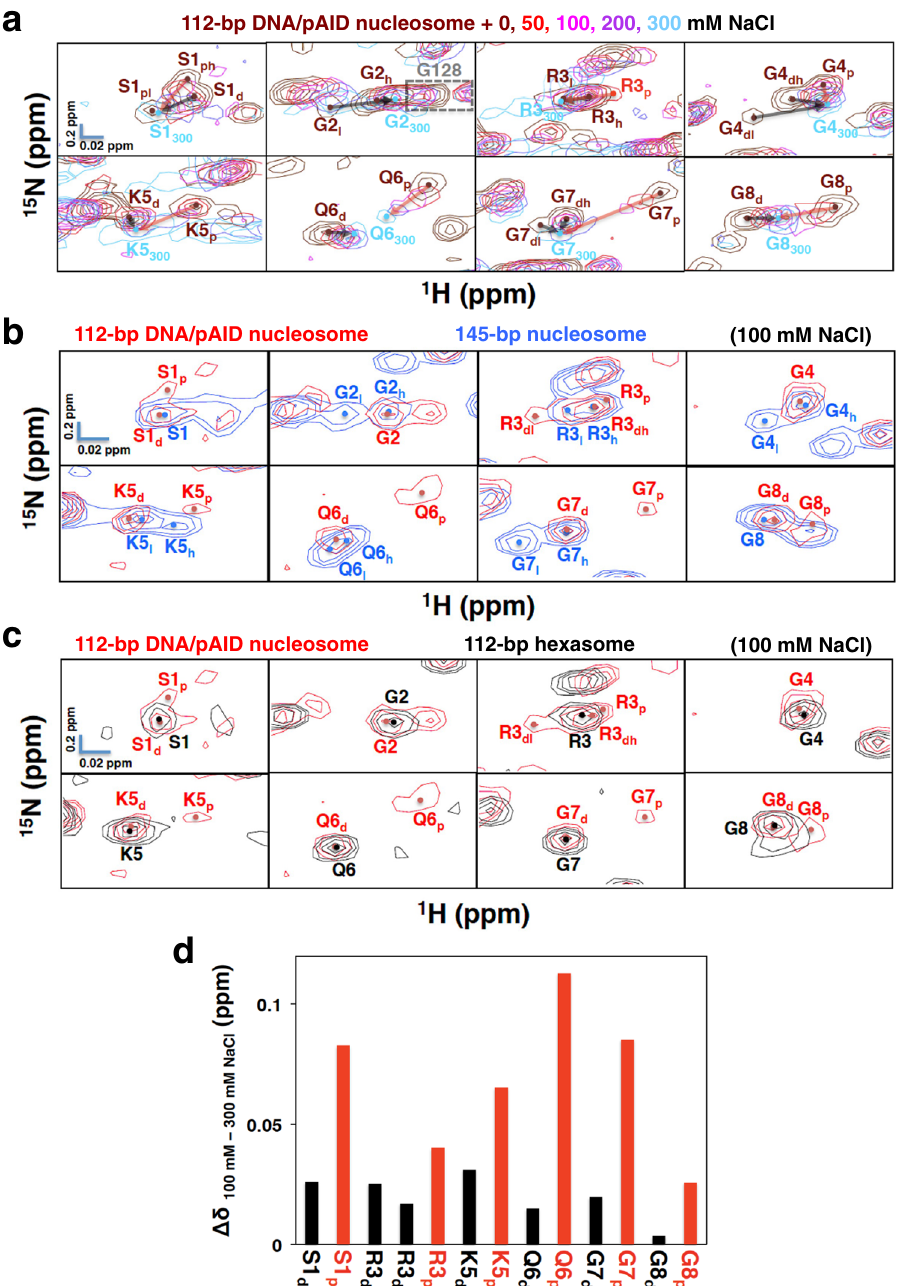
Fig. 4 Conformational comparison of the H2A N-tails under the physiological salt condition. a Ionic strength dependence of signals of the H2A N-tail in the 112-bp DNA/pAID nucleosome upon NaCl titration at 0 M (brown), 50mM (red), 100 mM (pink), 200 mM (purple), and 300 mM (cyan). NMR signals are divided into panels by amino acid residue. Residues are labeled in the color correspondingto the NaCl condition. Residues of the signal at 300 mM NaCl are designated by subscript 300. Red and black arrows indicate the chemical shift changes of the pAID and DNA side signals, respectively, between 0 or 50mM and 300mM NaCl. pAID and DNA side signals are designated by subscript p and d, respectively. High- and low- fi eld components of the signals are designated by subscript h and l, respectively. b , c Expanded signal comparison between the 112-bp DNA/pAID nucleosome (red) and the 145-bp nucleosome (blue) ( b ) or the 112-bp hexasome (black) ( c ) at 100 mM NaCl. NMR signals are divided into panels by amino acid residue (Ser1 – Gly8 of H2A). Signal assignments in the 112-bp DNA/pAID nucleosome, 145-bp nucleosome, and 112-bp hexasome are labeled in red, blue, and black, respectively. Filled circles indicate each signal center. d Histogram showing chemical shift differences between 100 mM and 300 mM NaCl of the pAID and DNA side signals in the H2A N-tail of the 112-bp DNA/ pAID nucleosome. Chemical shift differences are plotted for pAID side (red) and DNA side (black) residues in the H2A N-tail. H2A/H2B dimer or on the DNA side. In the 112-bp DNA/pAID elements (Supplementary Fig. 8c). This suggests that the H2A nucleosome at 0 mM NaCl, however, the chemical shift N-tails on both sides adopt a similar disordered structure, indices 56,57 of Gly4 – Gly8 in the H2A N-tail were very similar although they bind respectively to pAID and DNA with different between the pAID and DNA sides, showing no structural binding modes within nucleosome. COMMUNICATIONS BIOLOGY| (2022) 5:814